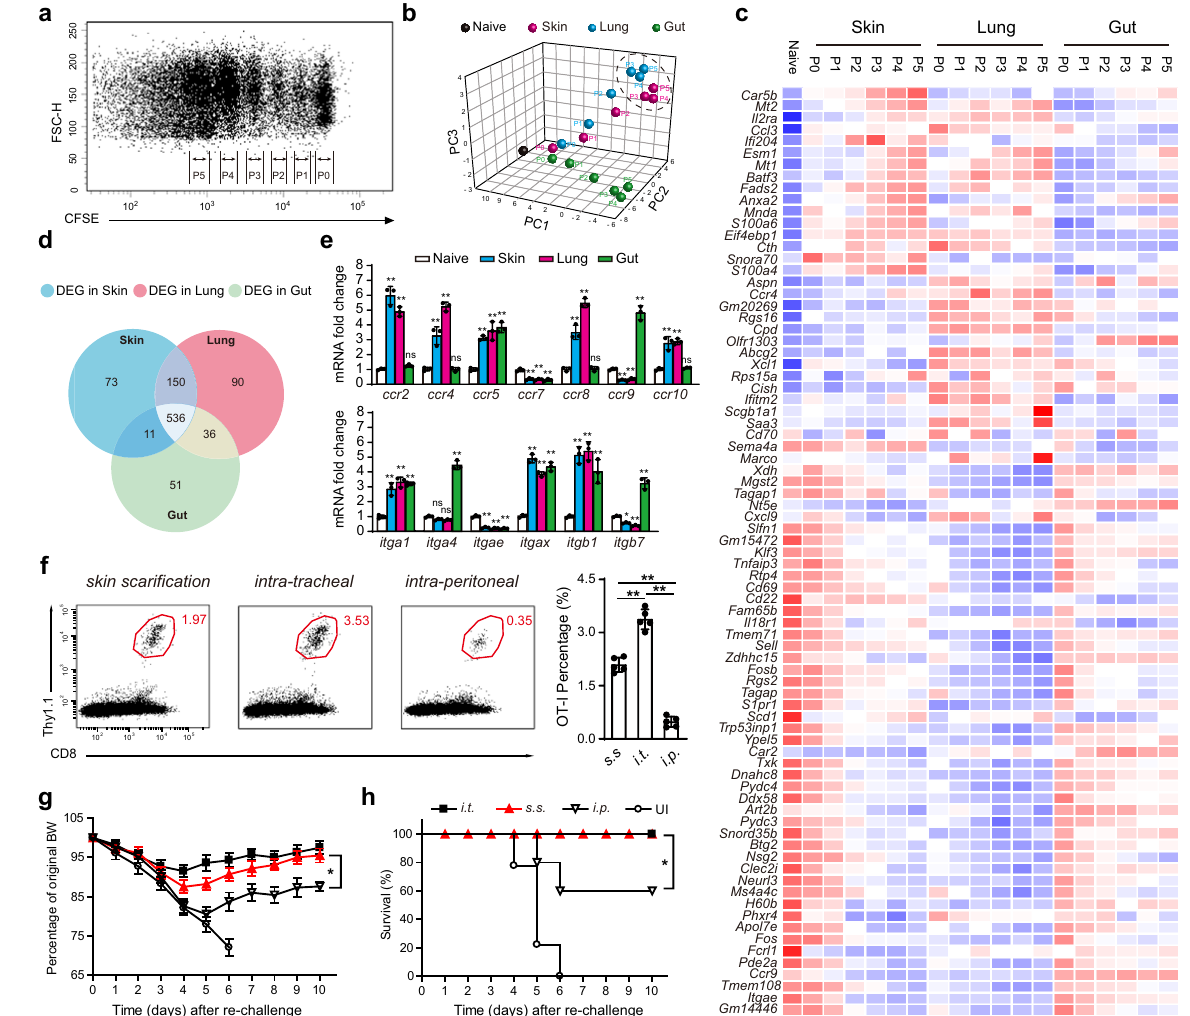
Fig. 4 MVA s.s. generates more than half number of lung T RM compared to intra-tracheal (i.t.) and is suf fi cient to protect mice against lethal respiratory challenge. a Flow cytometric analysis of OT-I cell proliferation in draining lymph nodes at 60 h post MVA infection via s.s. CFSE-labeled naive OT-I Thy1.1 + cells were transferred into Thy1.2 + recipient mice 1 day before mice were infected with 1.8 × 10 6 pfu MVA- Ova. b PCA of gene expression data for 19 CD8 + T-cell populations based on CFSE signal and different infection routes. Each dot represents an individual experiment wherein mRNA was pooled from 15 to 20 mice from 3 to 4 independent biological groups (5 mice/group). c Heatmap of differentially expressed genes selected from a pairwise comparison between s.s. and intraperitoneal (i.p.) activated T cells. d Venn diagram analysis of genes differentially expressed in pairwise comparisons between s.s., i.t., and i.p. activated T cells relative to T N (fold change cutoff, ≥ 2). e qRT-PCR analysis of cell homing molecule gene expression in s.s., i.t., and i.p. activated T cells. f Flow cytometric analysis (left) and quanti fi cation (right) of lung T RM cells at day 45 post MVA infection via indicated routes. g , h Body weight (BW) ( g ) and survival measurements ( h ) of WR-VACV re-challenged mice that were immunized previously with MVA via indicated routes 45 days earlier. OT-I WT cells were adoptively transferred into µMT mice before mice were infected with 1.8 × 10 6 pfu MVA via indicated routes. Forty- fi ve days later, mice were re- challenged with a lethal dose of WR-VACV by intranasal infection. DEG, differentially expressed genes. Graphs show the mean ± SD ( n = 5). UI = unimmunized. ns = not signi fi cant, * p < 0.05, ** p < 0.01. immunization. When T cells were collected from spleens at day 45 When used as a heterologous vaccine vector encoding for a after immunization, cells with T EM markers retained distinct T-cell antigen, MVA OVA delivered s.s. provided the earliest and best activation of OVA-speci fi c T cells (OT-1) in draining LNs at 60 h and transcriptional pro fi les, with i.m. immunization-generated T EM day 5 post immunization. In contrast, s.c. and i.m. immunization cells being most distinct from s.s. immunization-generated T EM generated the latest and lowest number of activated LN OT-I cells, cells. Day 45 memory T cells expressing CD62L (T CM ) showed as indicated by negative CFSE staining (Fig. 2a – d). These results smaller transcriptional differences between immunization routes, indicated that in addition to a different capacity to generate but s.s. generated T CM cells were still readily distinguishable from activated T cells, there are also differences in T-cell activation and those generated by i.m. immunization. These surprising data proliferation kinetics related to these different antigen delivery suggest that there are qualitative (e.g., transcriptional) differences routes. Interestingly, CD8 + T eff cells in skin-draining LNs at day in T eff and memory T cells (T M ) cells generated by immunization 5 showed different patterns of gene expression after immuniza- route that are evident by day 5 and persist at day 45. tion s.s., i.d., s.c., and i.m., respectively. T cells generated by i.m. There were also quantitative differences in T M generation were most distinct transcriptionally from those generated by s.s. depending on route of administration. Immunization via s.s. Published in partnership with the Sealy Institute for Vaccine